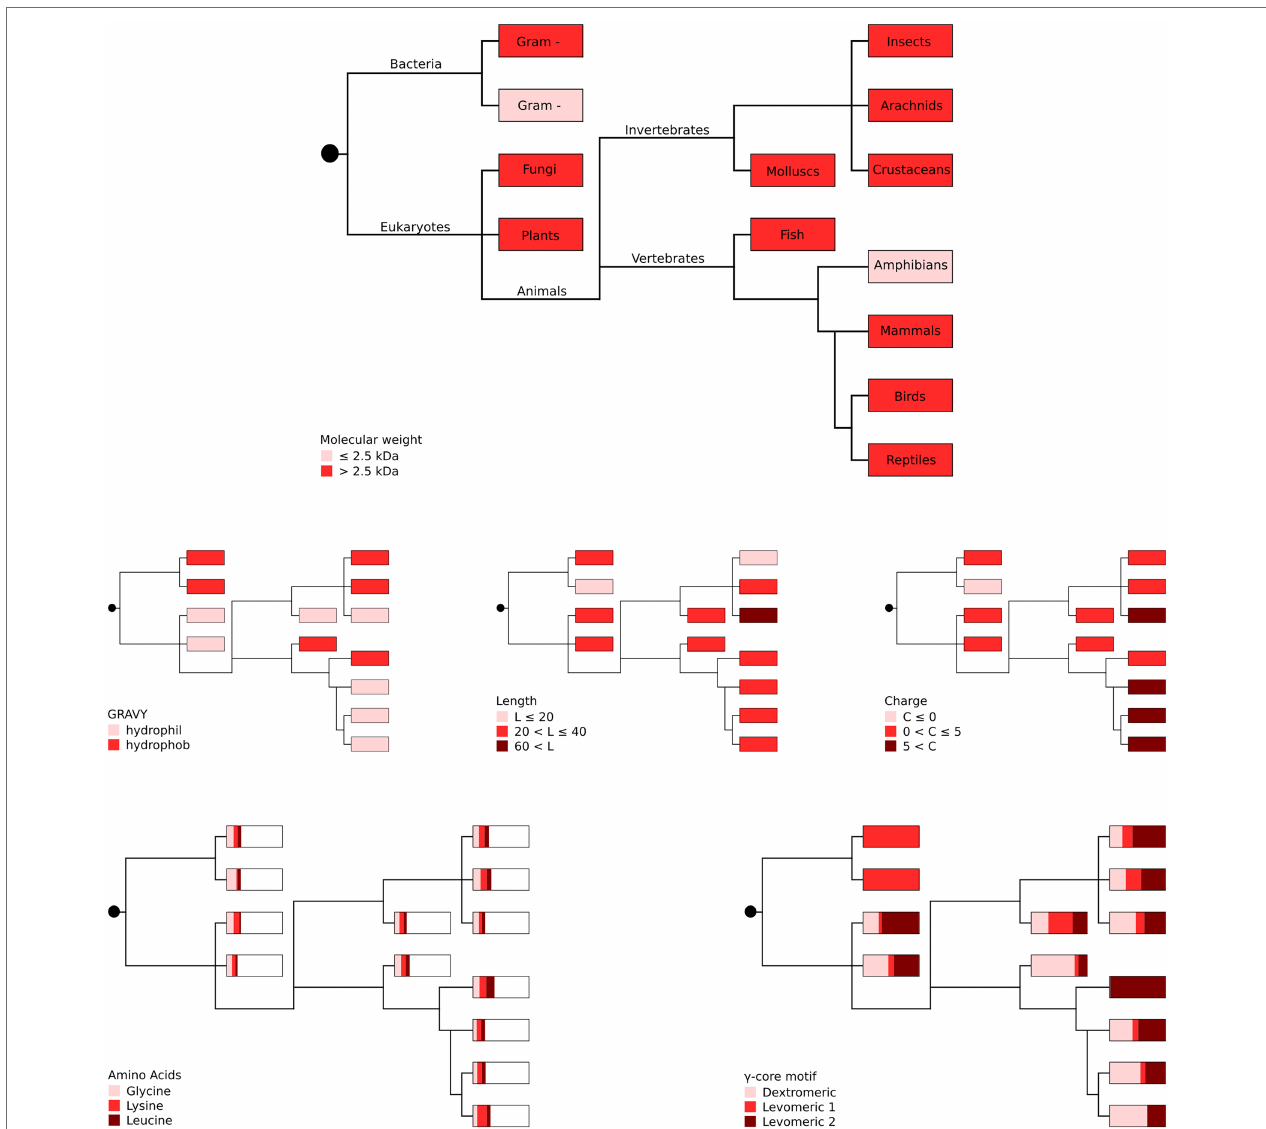
FIGURE 3 | Phylogenetic representation of the most abundant AMP properties per producing organism group. The most abundant amino acids (glycine, lysine and leucine) as well as the different γ -core motifs are given as proportions with boxes representing 100%. Gram + represents Gram-positive and gram – represents Gram-negative bacteria. Distribution of the taxonomic groups is as labelled in the top panel. Each phylogenetic tree has its own colour legend and is related to one of the following AMP properties (as stated in the figure): molecular weight, GRAVY, length, charge, amino acids and γ -core